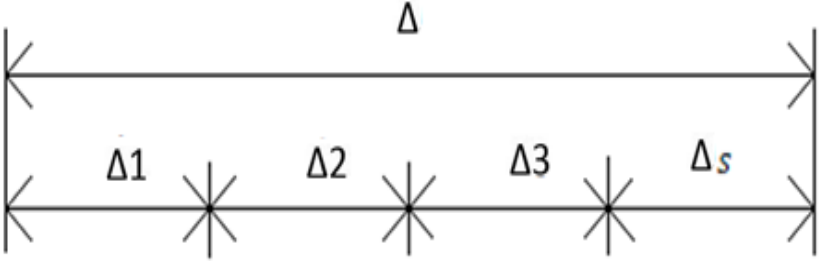
Figure 6. Deformation condition for solving the statically indeterminate issue (Δ = displacement caused by headless screw tightening, Δ1 = extension of the screw, Δ2,3 = shortening of bone fragments due to axial compression, and Δs = displacement of the inner sensor cylinder in the measuring).